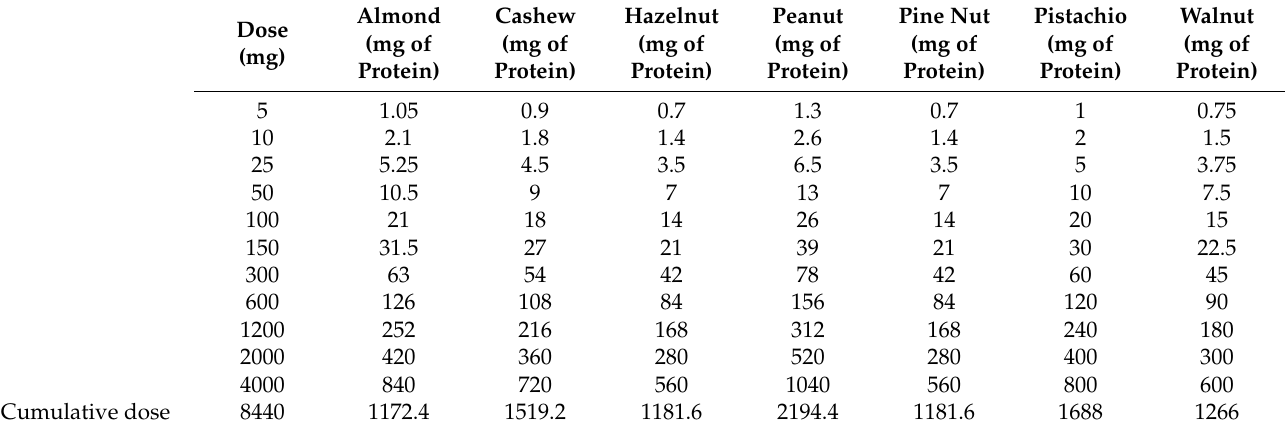
Table 1. Nut oral food challenge